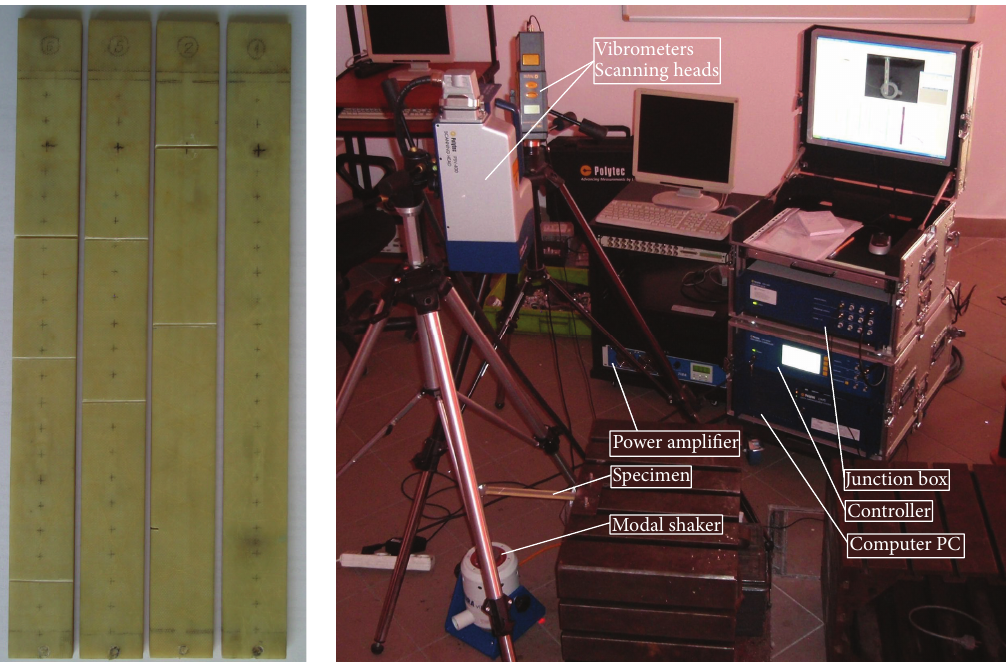
Figure 1: Specimens with multiple cracks and experimental setup.